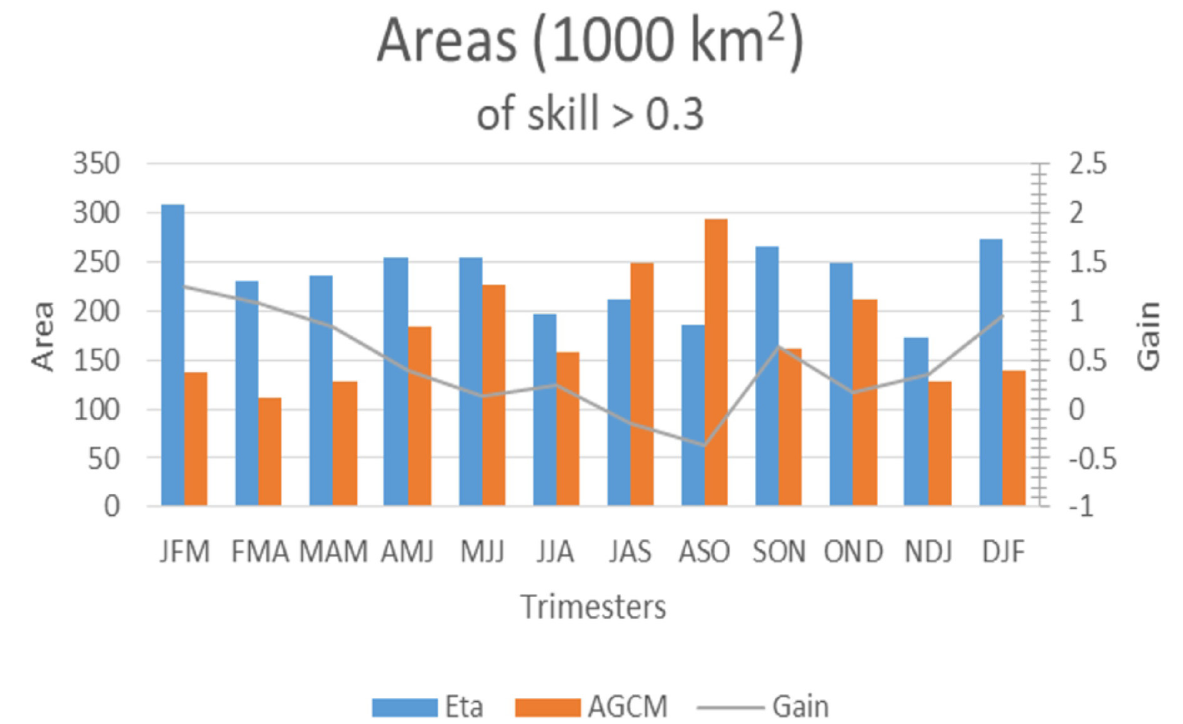
Figure 13. Total area (1000 km 2 ) where the seasonal precipitation skill score is over 0.3 for the Eta RCM (blue bars) and for the CPTEC global atmospheric climate model (red bars). The gain ratio is shown on the right axis (curve,